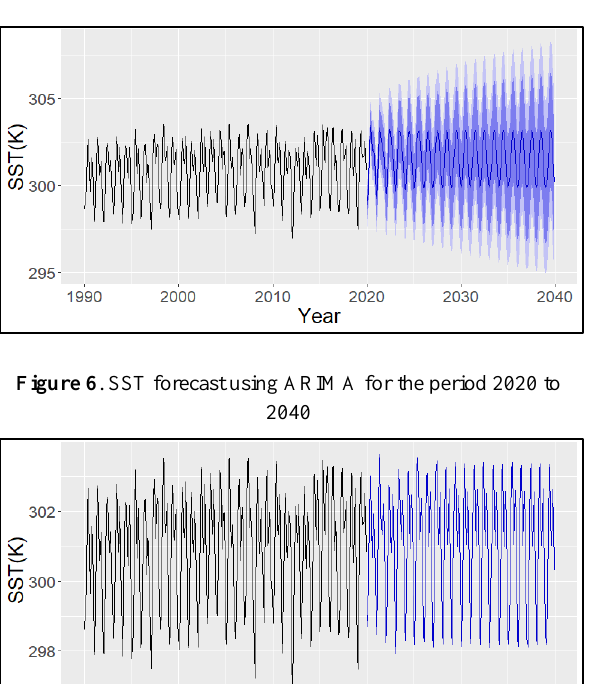
Figure 5 . ARIMA & NNAR model validation